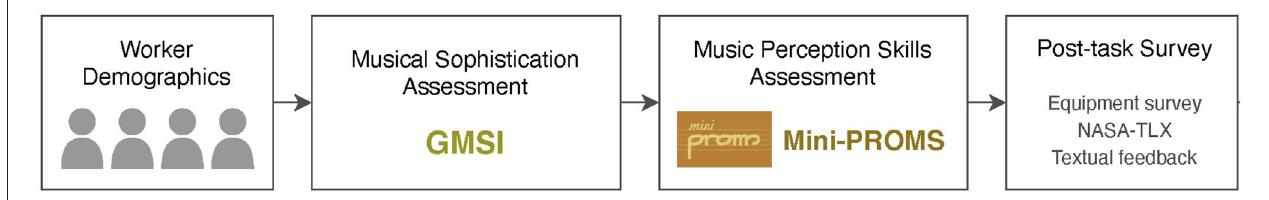
FIGURE 1 | The four steps in the music perception skills